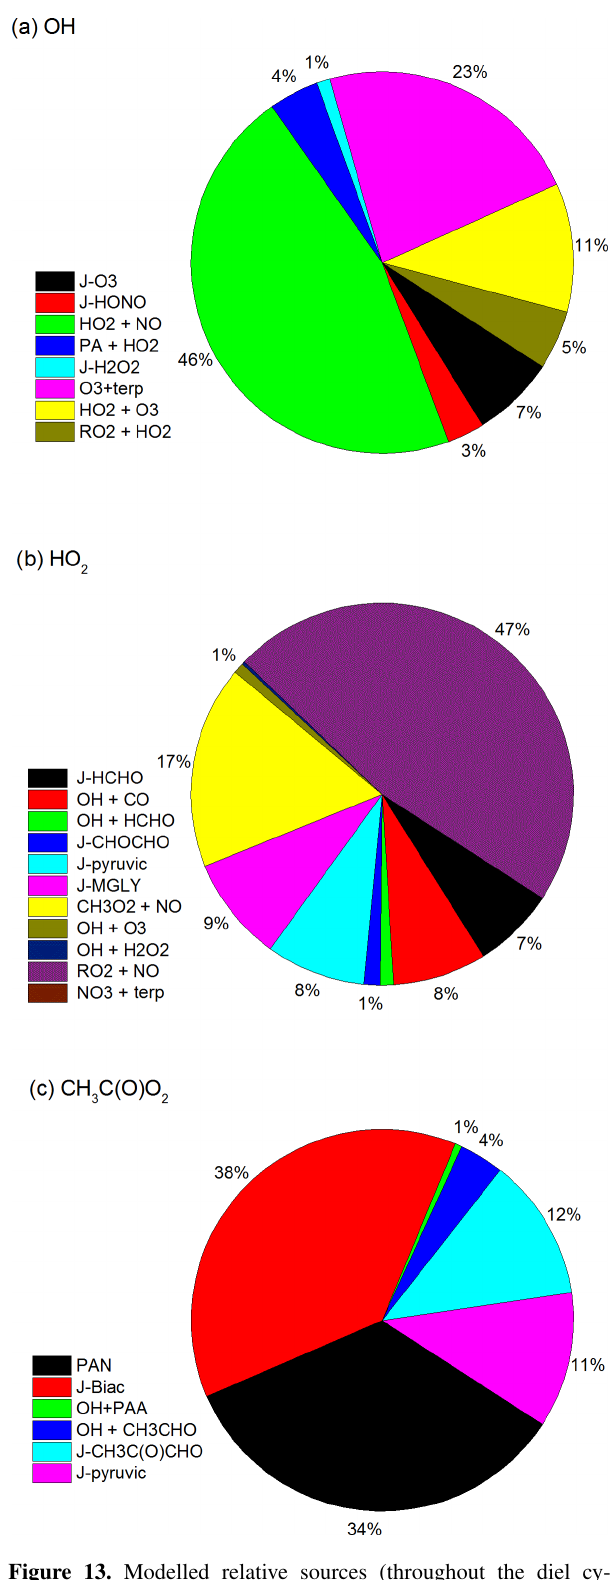
Figure 13. Modelled relative sources (throughout the diel cy- cle) of OH, HO 2 and CH 3 C(O)O 2 during HUMPPA-COPEC-2010 (days